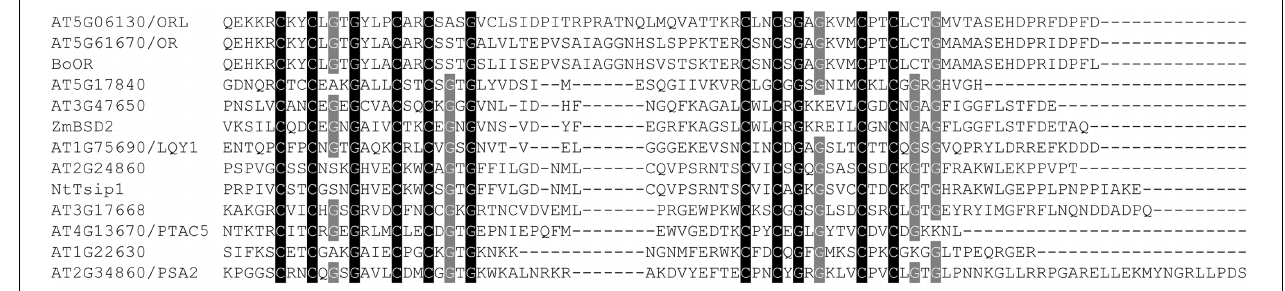
FIGURE 1 | Alignment of the C-terminal regions of DnaJ-like zinc finger domain proteins in Arabidopsis thaliana . Previously reported members from other plant species, including BSD2 from maize (ZmBSD2), OR from cauliflower (BoOR) and Tsip1 from tobacco (NtTsip1) were also incorporated. Sequences were aligned using ClustalX and manually edited. Conserved amino acid residues of the zinc finger domain were